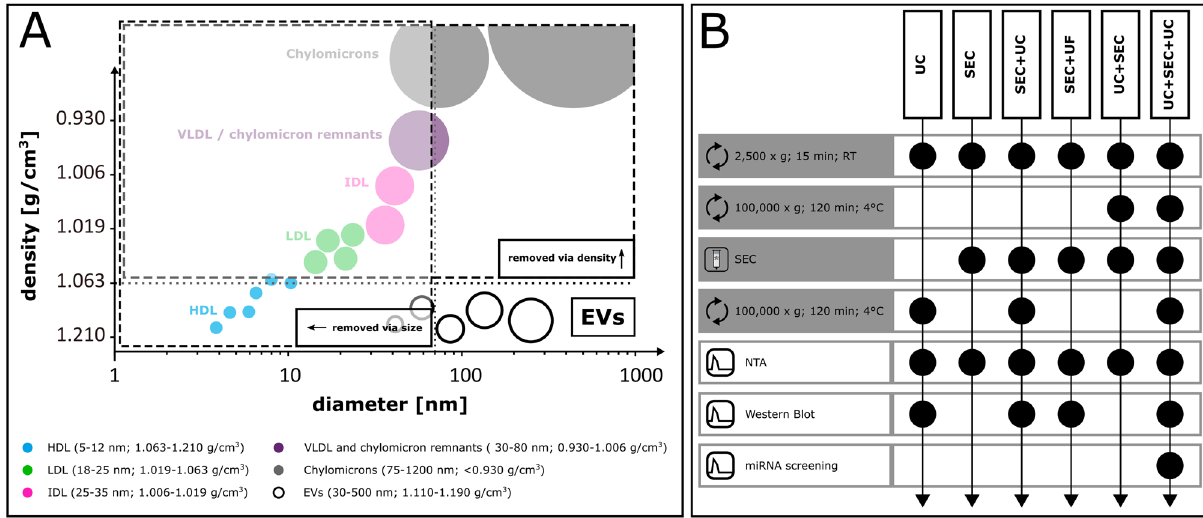
Figure 1. ( A ) Rationale behind using density- and size-based EV isolation techniques in tandem to deplete non-EV particles from plasma or serum (modified after 21 ). ( B ) Overview of isolation procedures investigated in this study. Black dots indicate that the preparative step (grey row labels) or analytic step (white row labels) was a task in the